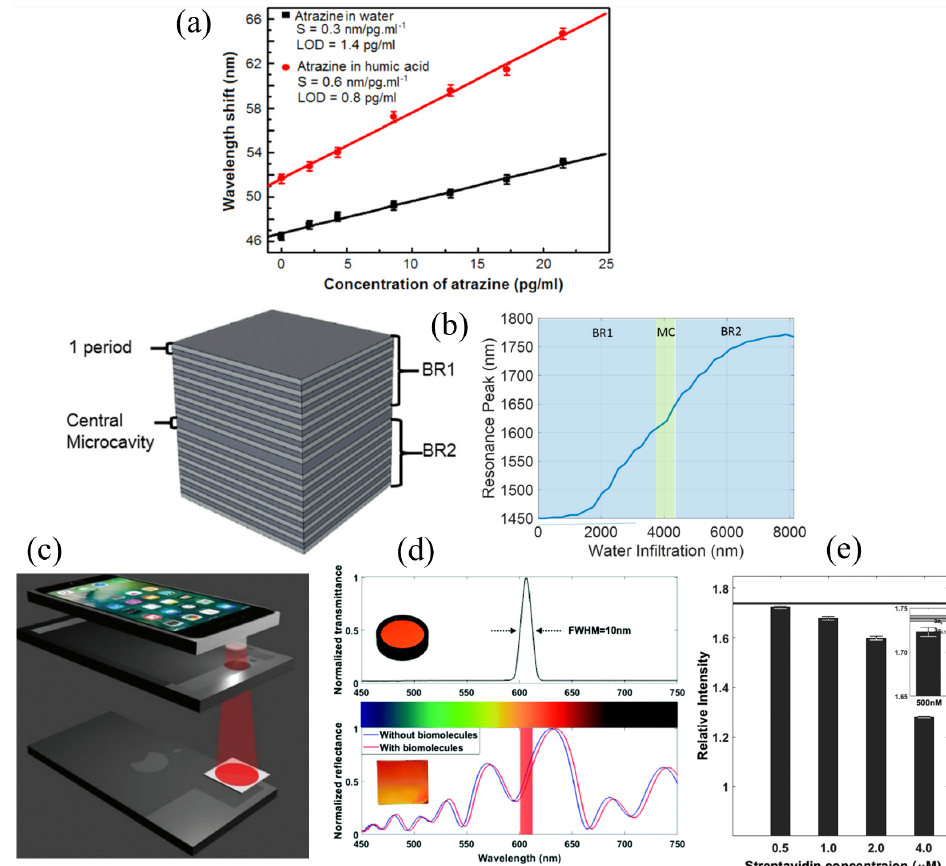
Figure 9. ( a ) Detection of the atrazine pesticide in two different buffers. Reproduced from